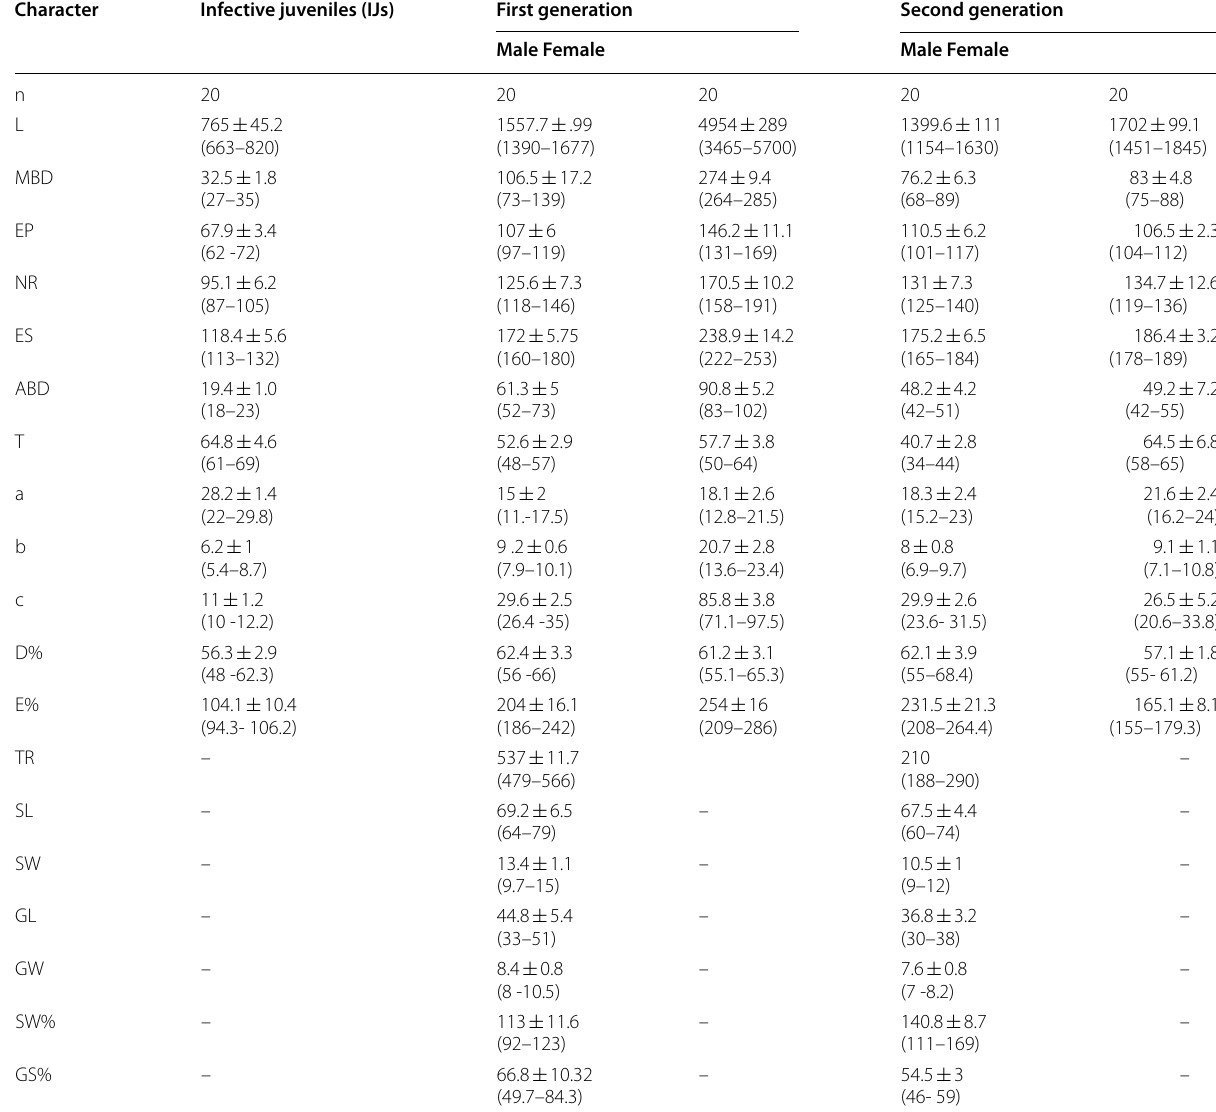
Table 3 Morphometrics of Steinernema affine